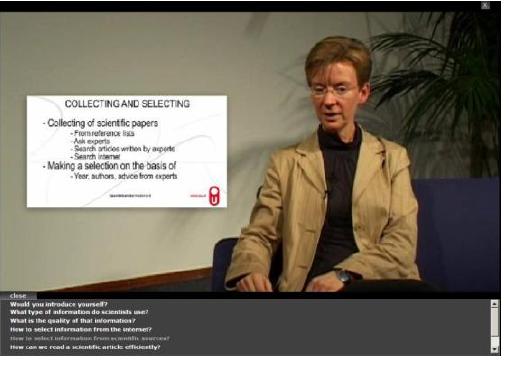
Figure 3. Senior researcher (NPC) at the virtual company while giving feedback to a task. The feedback is given in video.